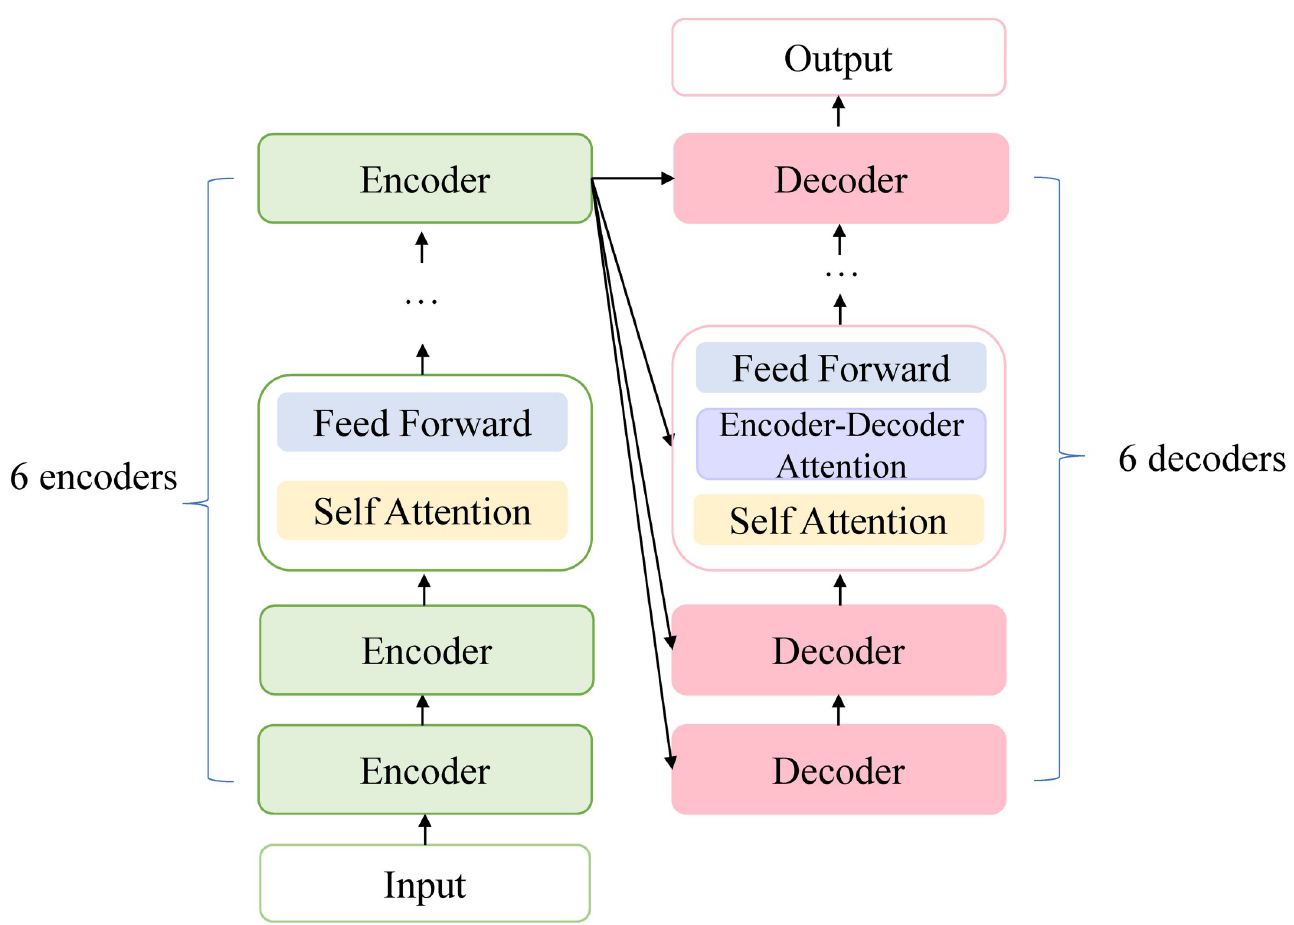
Fig 1. The transformer structure used in